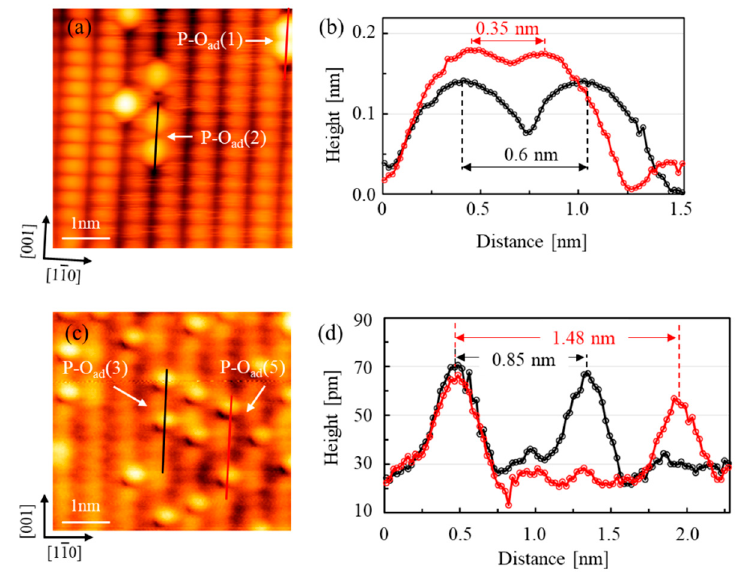
Figure 3. ( a ) AFM images on TiO 2 (110) surface. ( f 0 = 802 kHz, Q = 13001, ∆ f = − 80 Hz, V DC = 0.4 V, A = 500 pm, 5 × 5 nm 2 , O 2 exposure at RT). ( b ) Line profiles along the oxygen adatoms in (a). ( c ) AFM images on TiO 2 (110) surface. ( f 0 = 795 kHz, Q = 6329, ∆ f = − 231 Hz, V DC = 0.4 V, A = 500 pm, 4.5 × 5 nm 2 , O 2 exposure at 400K). ( d ) Line profiles along the oxygen adatoms in (c).